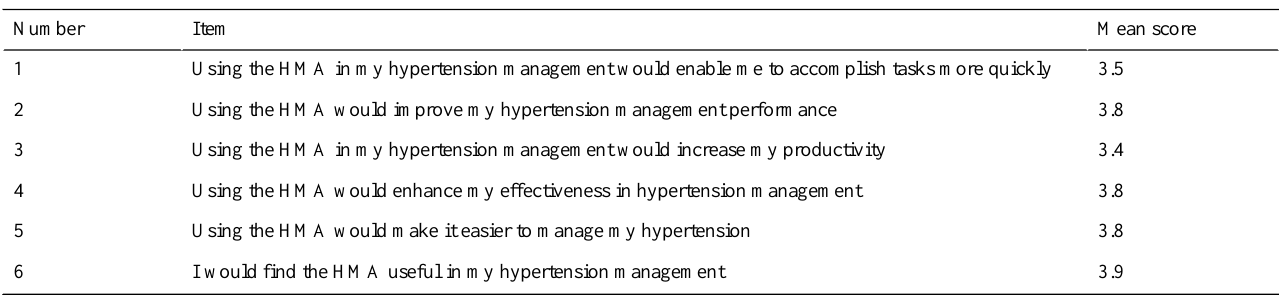
Table 6. Perceived usefulness score by item.